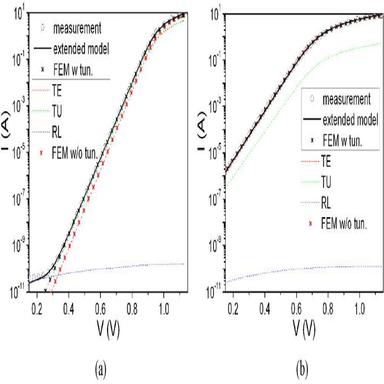
Comparison of the measurement with FEM simulation and extended model for temperatures of 25 C (a) and 200 C (b).